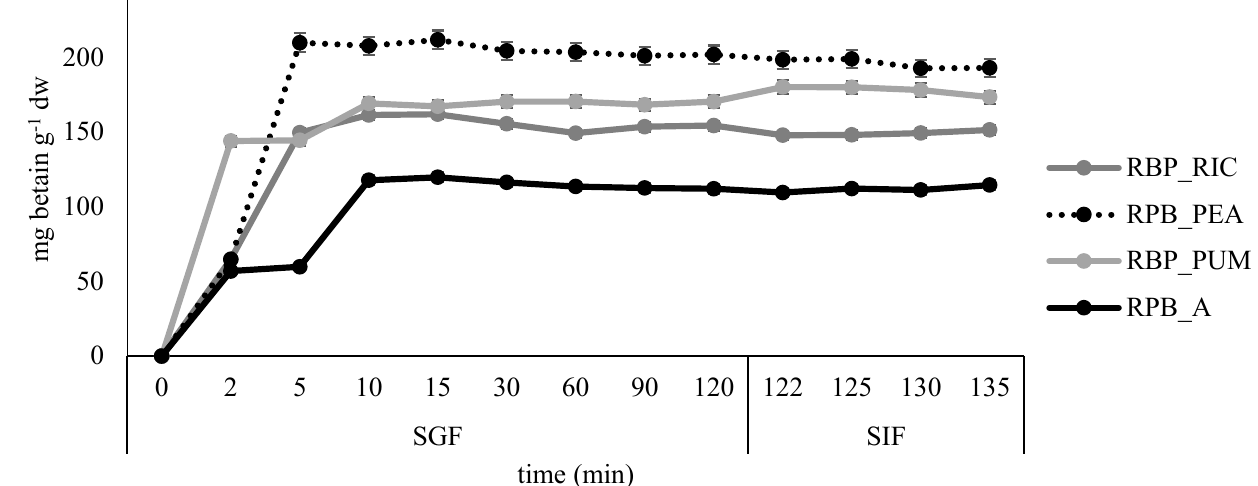
Figure 8. Release profile of betacyanins in simulated gastro-intestinal digestion for the edible films prepared from red beetroot peel extract.